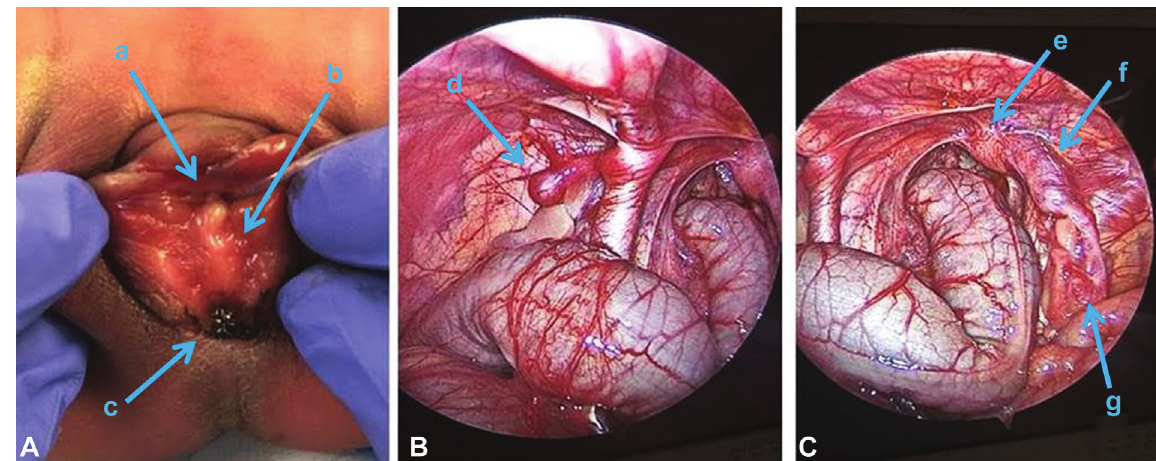
Fig. 1 ( A ) Physical exam showing meconium passing through posterior portion of introitus, with no vaginal ori fi ce in location expected. ( B ) Diagnostic laparoscopy showing a left atretic fallopian tube with intact ovary. ( C ) Diagnostic laparoscopy showing an intact right fallopian tube with intact ovary. a. Urethra. b. Introitus. c. Rectum. d. Left atretic Mullerian system. e. Right obstructed vagina. f. Right patent uterus. g. Right patent fallopian